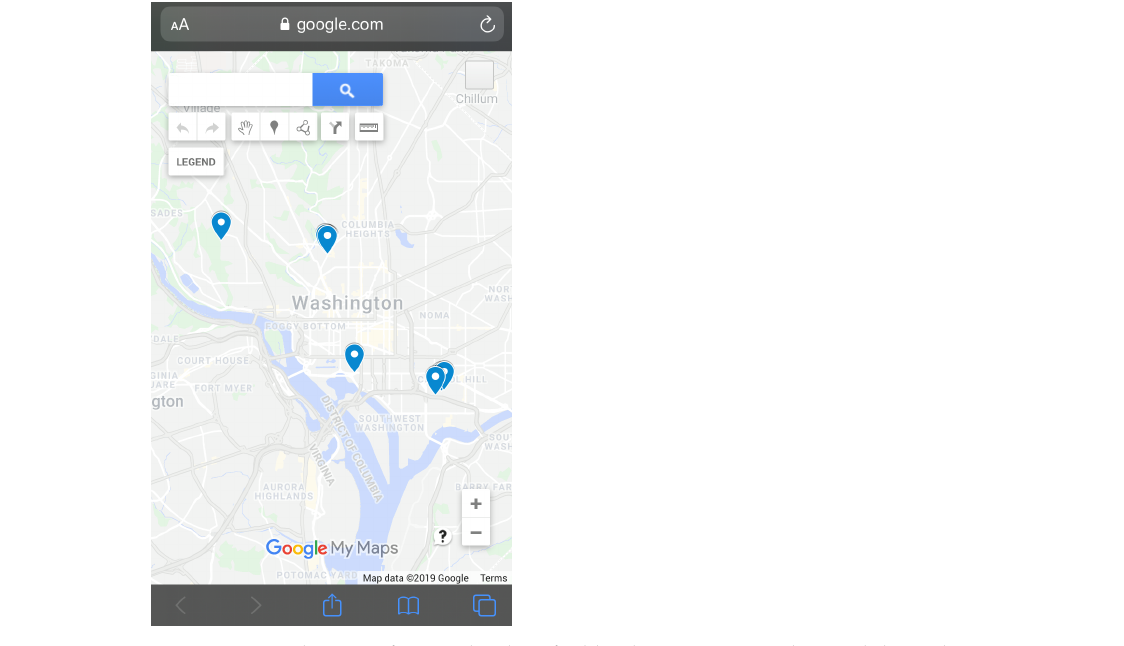
Figure 7. Google Map of correctly identified lambsquarters as submitted through Mission LQ.